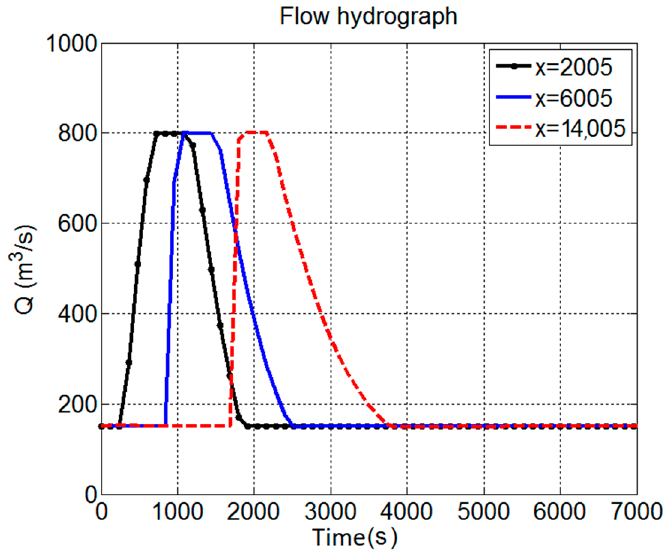
Figure 12. Wave translation hydrographs at different locations along the modelled channel.